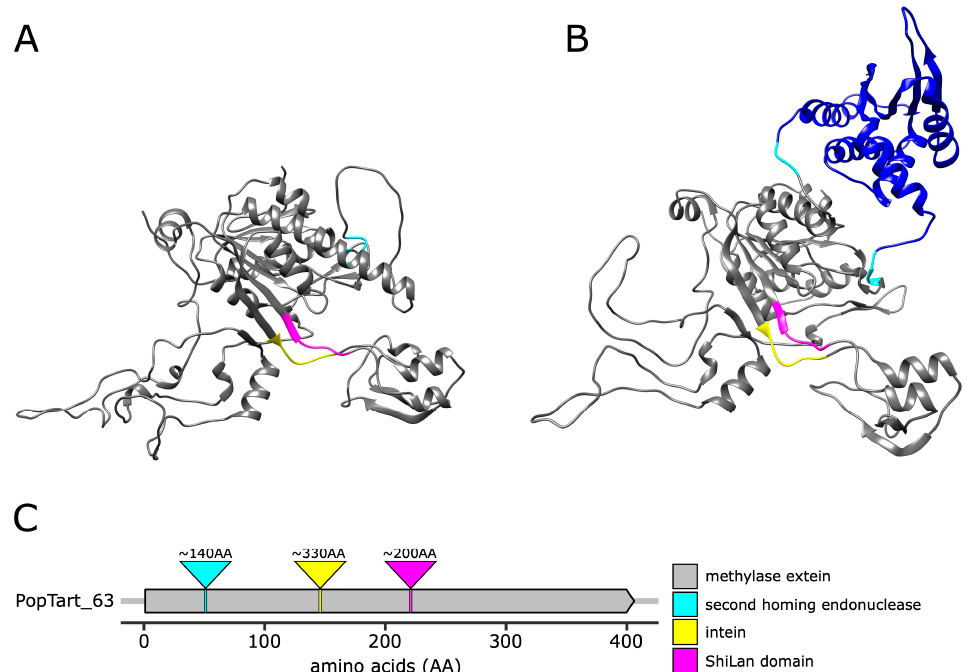
Figure 4. Location of insertion sites of the second LAGLIDADG homing endonuclease domain, the intein, and the ShiLan domain mapped onto predicted methylase structures (panels A and B ) and the linear sequence of insertion-free methylase PopTart_63 (panel C ). The structure of the PopTart_63 (panel A ) and Taj_79 (panel B ) methylases were predicted by AlphaFold v2.2.4. Three residues upstream and downstream of each element’s insertion site are indicated as follows: ShiLan domain in magenta, intein in yellow, and the second homing endonuclease in cyan. The putative homing endonuclease domain in Taj_79 is in blue. The model confidence for the two structures is depicted in Figure S2. Panel C gives the approximate size and location of the insertions mapped onto the PopTart_63 gene. The second homing endonuclease domain and the intein in Akhila_67 have a length of 139 and 327 amino acids, respectively. The ShiLan domain in Mantra_64 is 202 amino acids long.